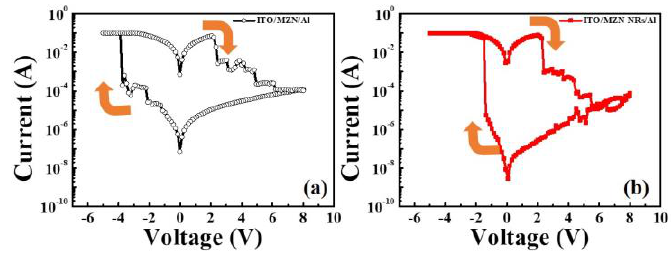
Figure 5. Typical I – V curves of: ( a ) Al/MZN thin film/ITO structure; and ( b ) Al/MZN NR/ITO structure.